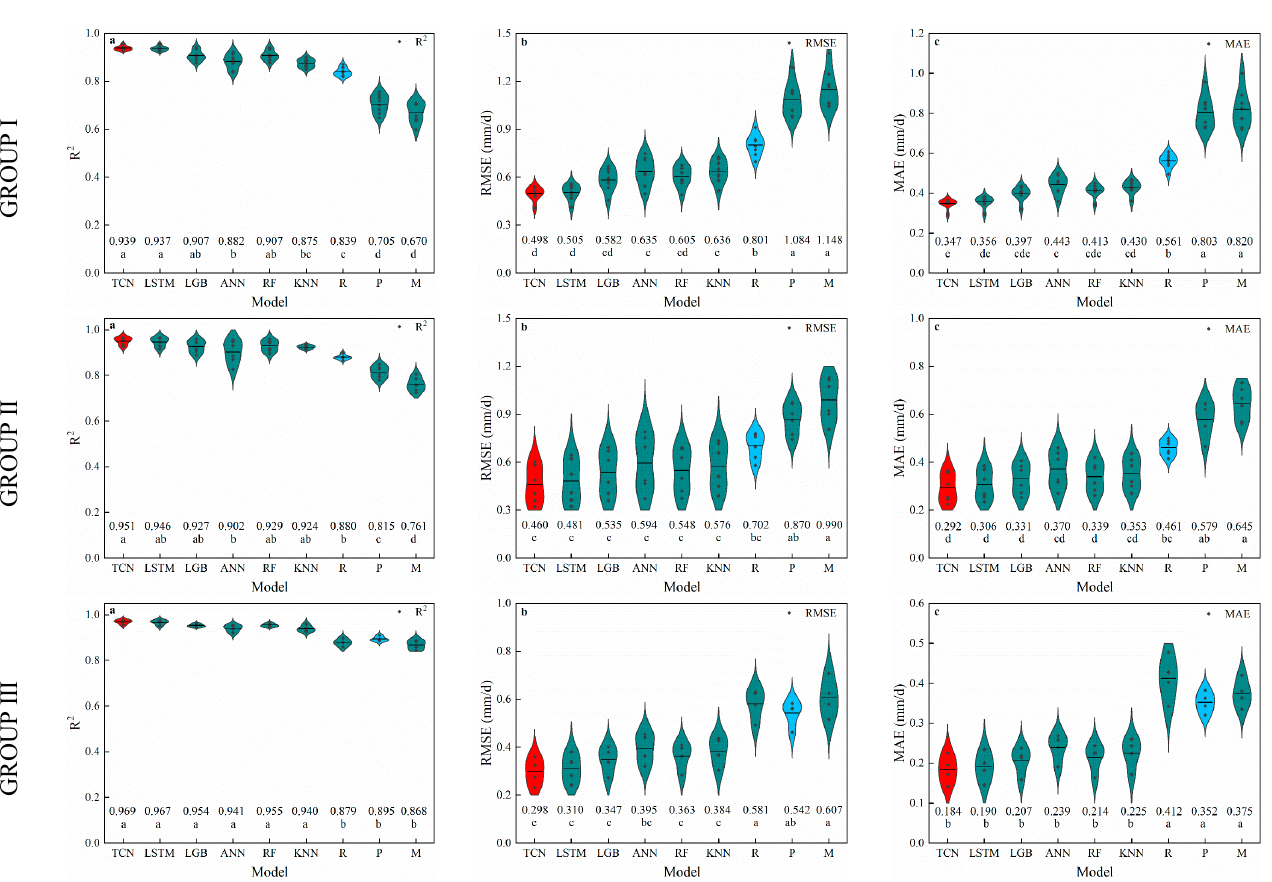
Figure 5. The performance of the radiation-based models during the first strategy: ( a ) determination coefficient (R 2 ), ( b ) root mean square error (RMSE), and ( c ) mean absolute error (MAE).